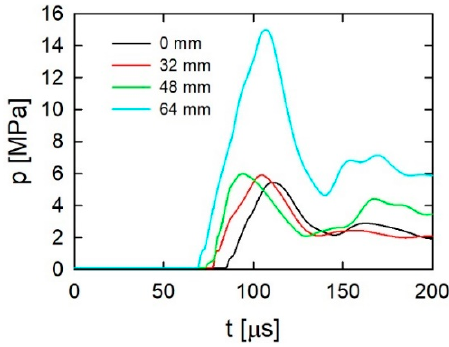
Figure 18. Initial parts of calculated pressure courses at the end of the chamber for sleeves of various lengths.